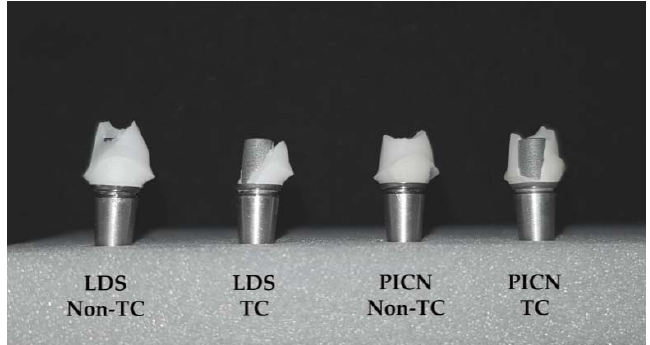
Figure 8. Macroscopic image showing failures of LDS and PICN hybrid abutments after fracture-resistance test. Failure within ceramic material was detected at nonthermocycled LDS and PICN abutments and ceramic detachment was observed at thermocycled hybrid abutments (LDS TC and PICN TC).